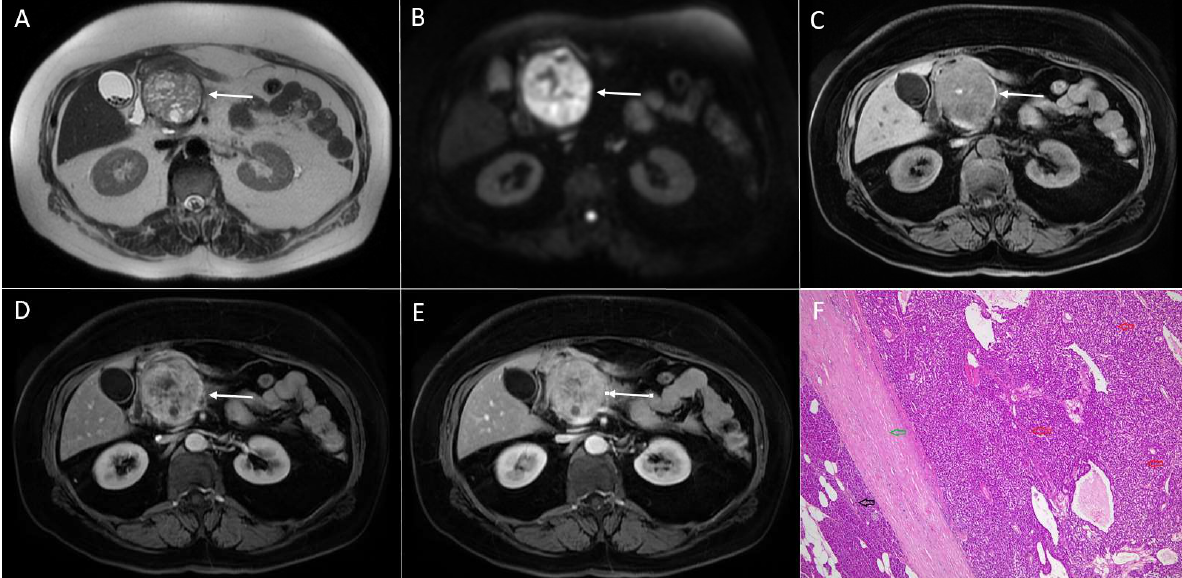
Figure 16. Neuroendocrine tumor in 43-year-old woman. Axial T2-weighted image ( A ) shows round heterogeneous lesion with internal hyperintense areas ( arrow ) located in the pancreatic head. On DWI, the tumor displays high signal intensity ( B ). The lesion ( arrow ) is hypointense on native T1-weighted FS image with small hyperintense focus centrally located ( C ). In arterial phase ( D ), the tumor shows intense heterogeneous enhancement, which persists in portal-venous phase ( E ). Hematoxylin and eosin (H&E) staining ( F ) showed neuroendocrine tumor G3 ( red arrows ). Normal pancreatic parenchyma ( black arrow ) is also seen separated from the tumor by thick fibrous capsule ( green arrow ); original magnification ×400.